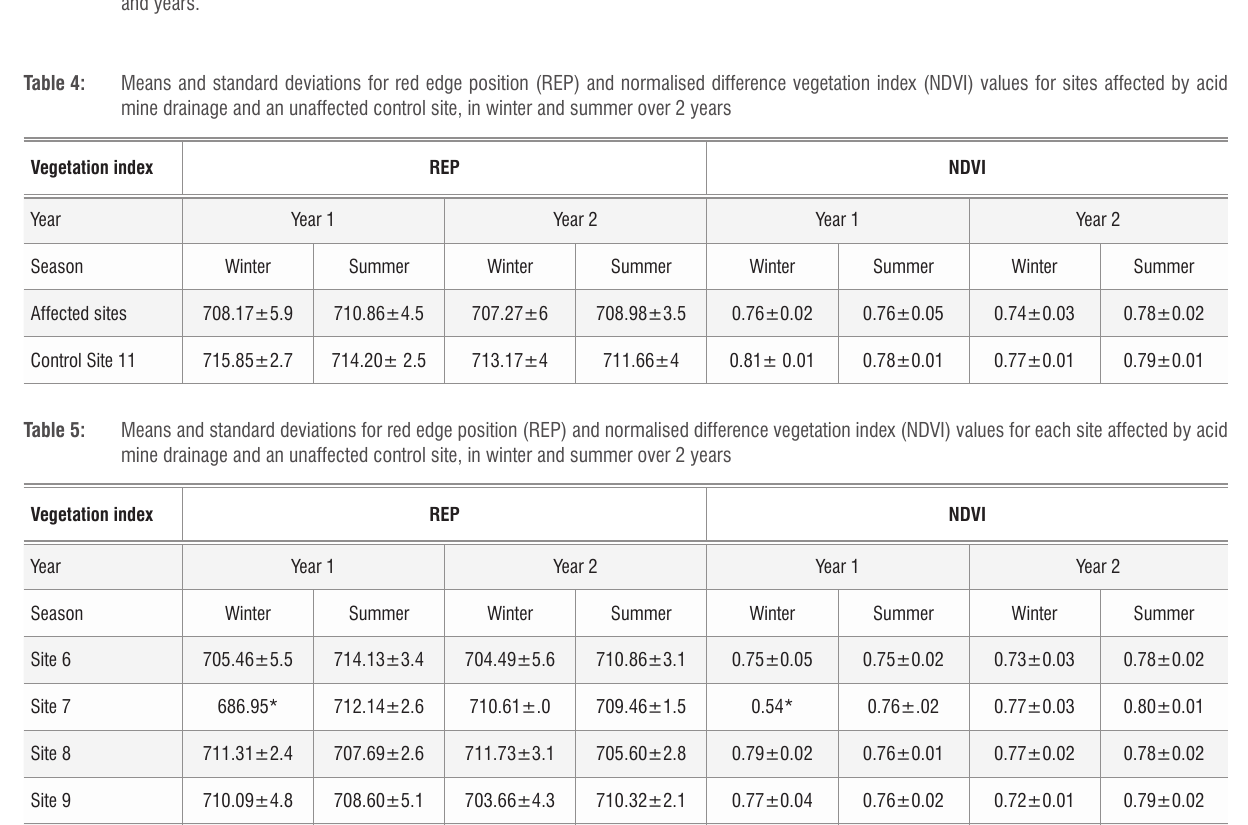
Figure 7: Comparison of first derivative reflectance (FDR) curves for Sites 6–9 and 11. Only a single new growth green leaf was available on the day of sampling at Site 7 in winter of Year 1. In winter, Site 6 shows a dominant first peak in the FDR whereas the control and Waterfall sites show dominance of the second peak of the red edge in the FDR. In the summer of both years, chlorophyll levels increased, as is shown by the dominance of the second peak for most sites. Control Site 11 shows consistency in the second peak of the red edge FDR for both seasons and years.